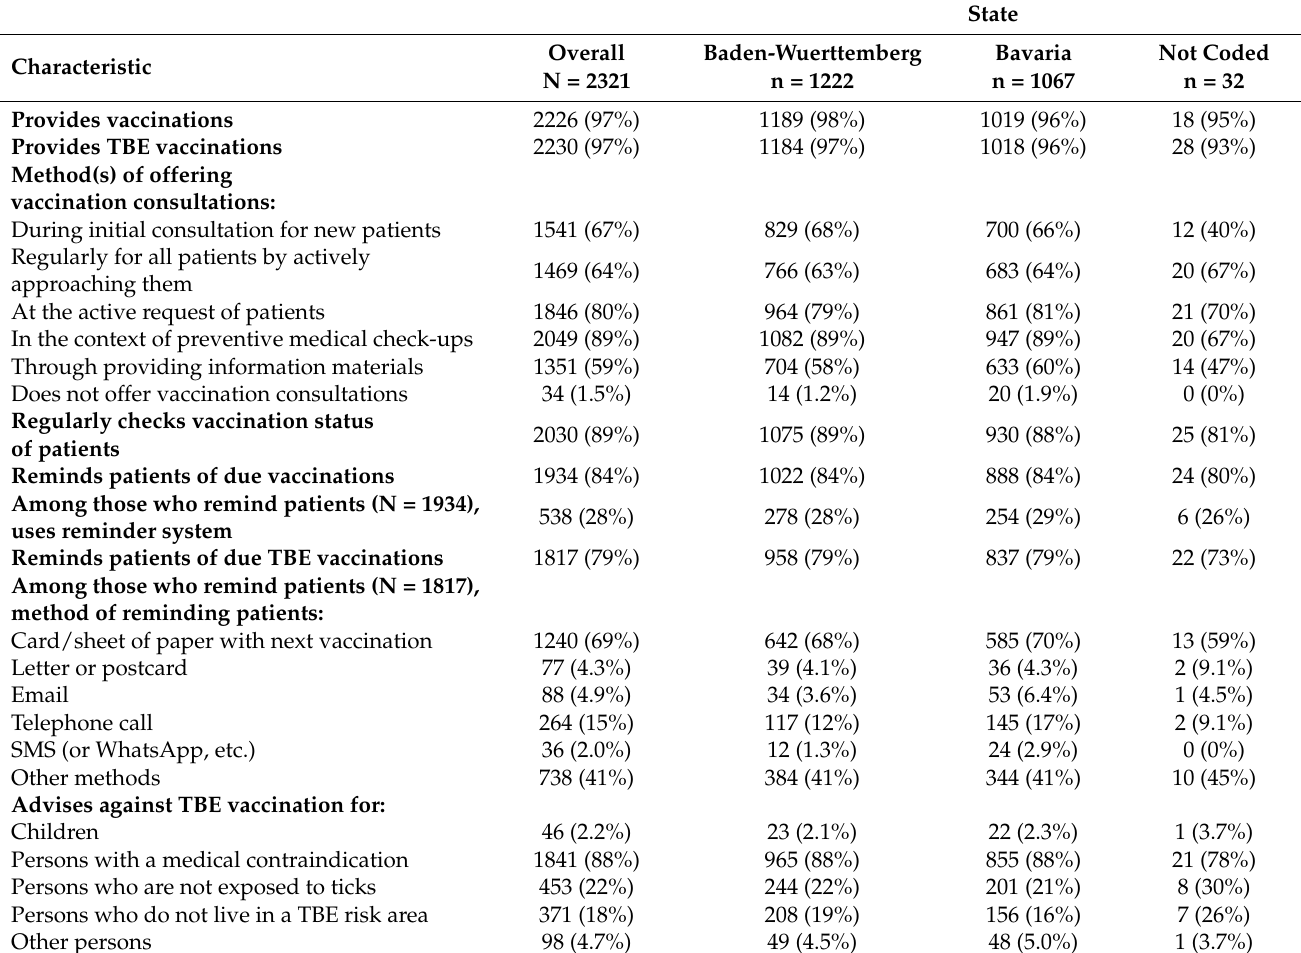
Table 3. Vaccination practices of primary care physicians participating in the TBD-Prev